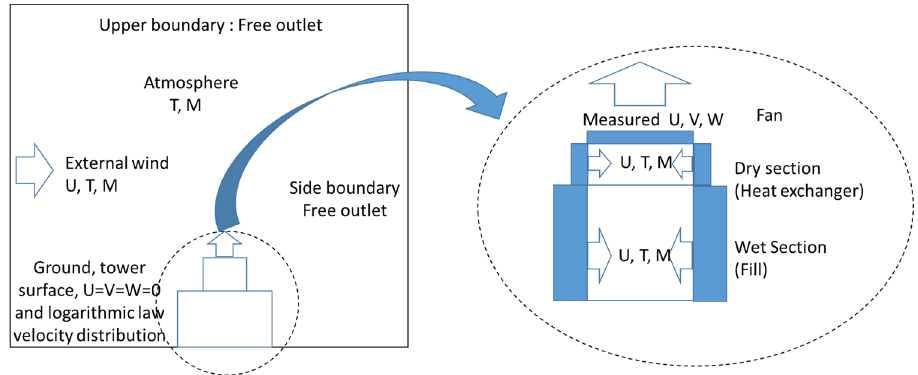
Figure 4. Initial and boundary conditions for the numerical Figure 4 . Initial and boundary conditions for the numerical calculations.